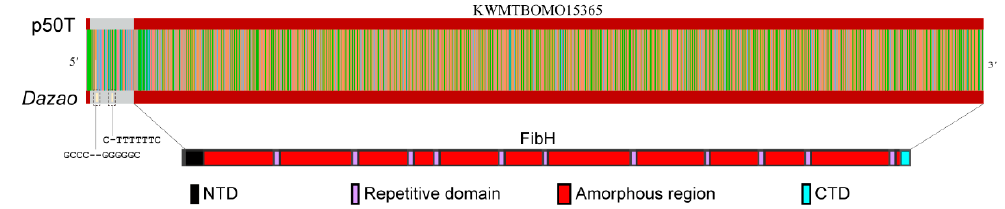
Figure 3. The coverage depth of the target region by Cpf1-based enrichment and ONT sequencing (CEO). ( A ) The length distribution of reads compared to the target region. The horizontal axis is read numbers numbered from high to low according to the read length; the vertical axis is the length of the reads compared to the target region. ( B ) Line a is the depth of read coverage; line b is the position of the crRNA sequence alignment and is marked with the name of the crRNA sequence, and the green line is its position; line c is the read alignment; line d is the gene annotation.